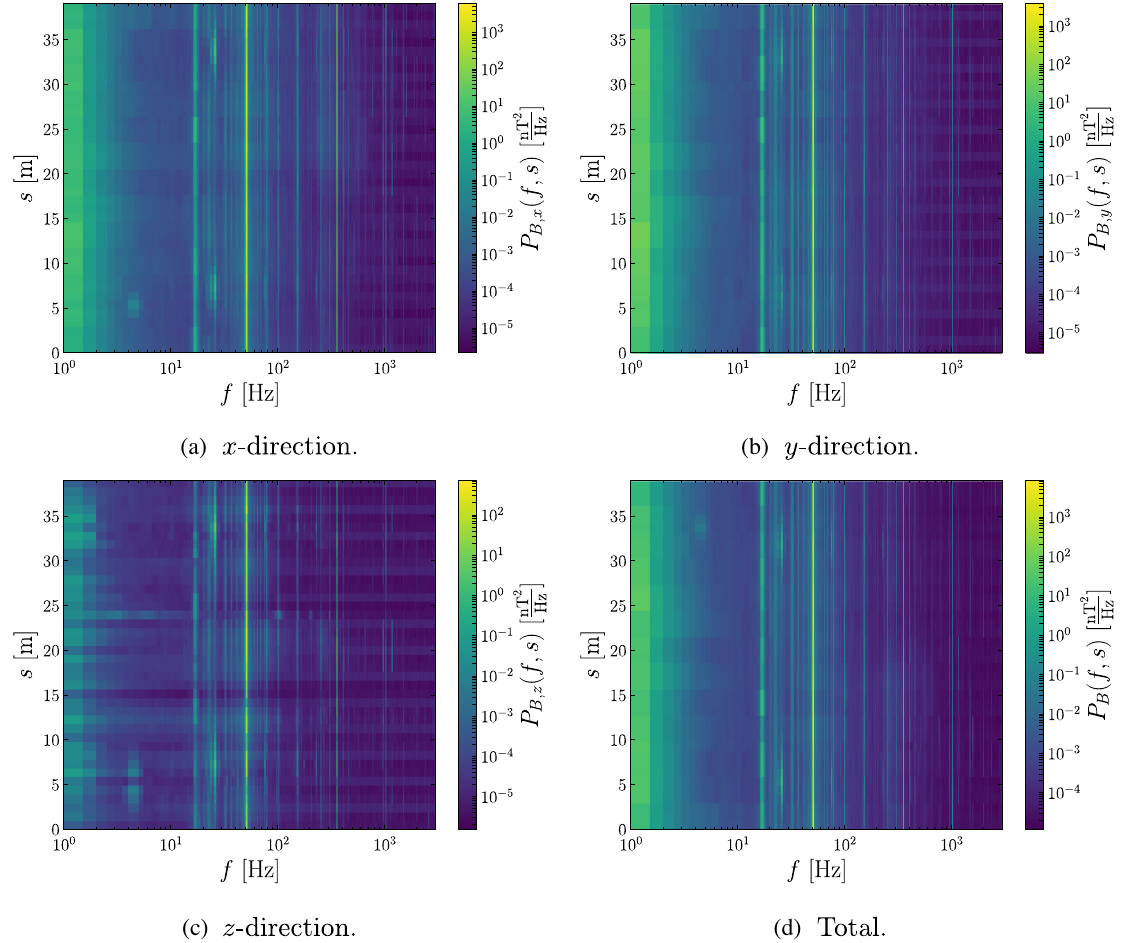
FIG. 4. PSD of the magnetic field (right-hand side scale) in the x , y and z -direction, P B;x ð f; s Þ , P B;y ð f; s Þ and P B;z ð f; s Þ respectively, and total PSD P B ð f; s Þ vs location s (left-hand side scale) and frequency f .